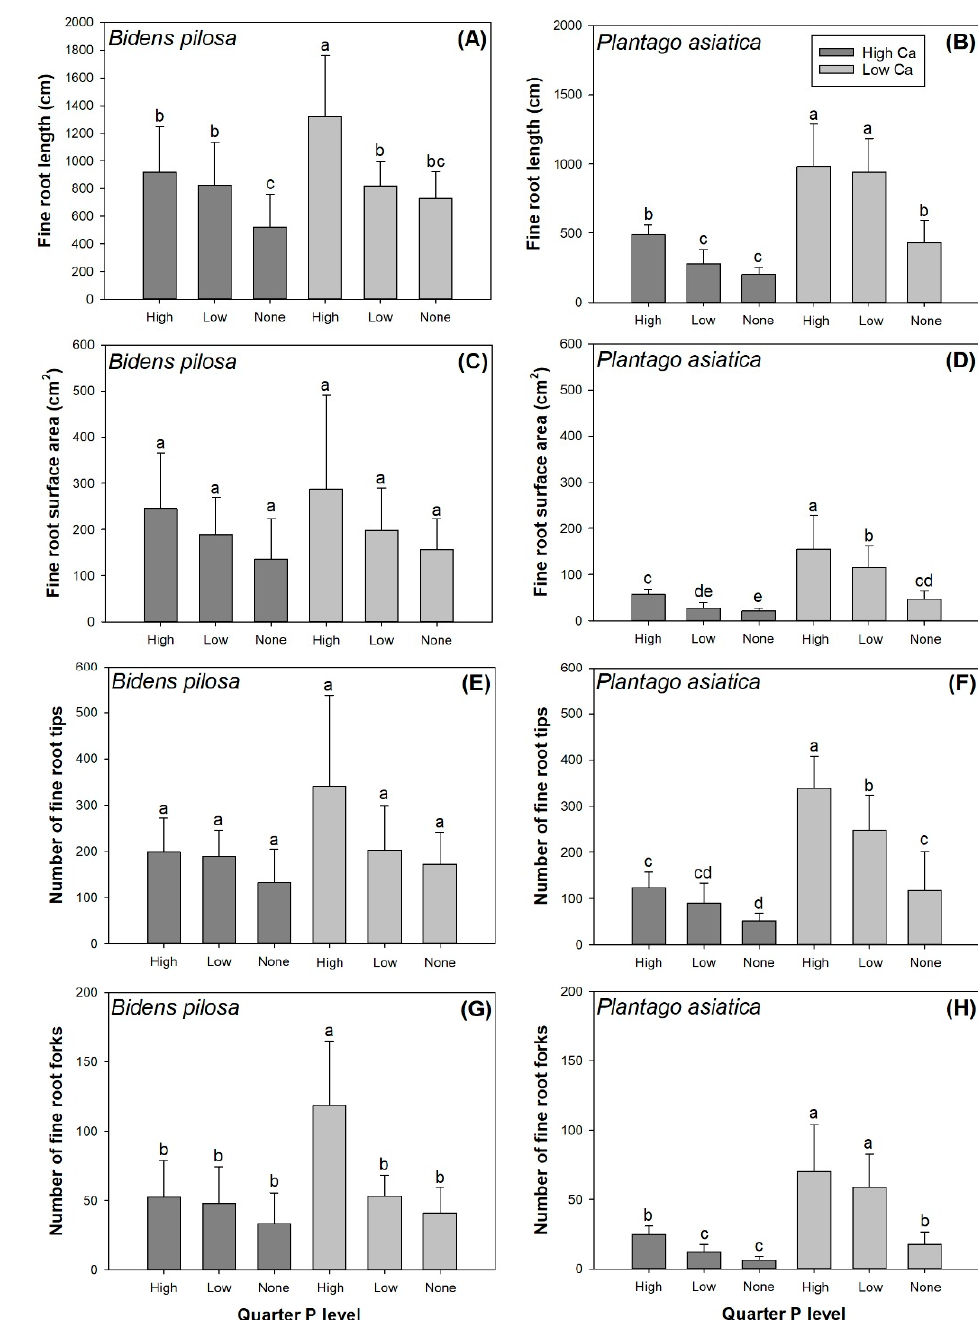
Figure 2. Fine root length ( A , B ), surface area ( C , D ), tip number ( E , F ), and fork number ( G , H ) in Bidens pilosa and Plantago asiatica plants subjected to phosphorus (P) input to quarters of pots at rates of 0 (none), 2 (low), and 8 mg kg − 1 (high) at high calcium (Ca) (2 g kg − 1 ) and low Ca levels (0.63 g kg − 1 ). Error bars stand for standard errors. Same letters in a cell of figure indicate the failure to find significant difference by Duncan’s new multiple range test at the p < 0.05 level.